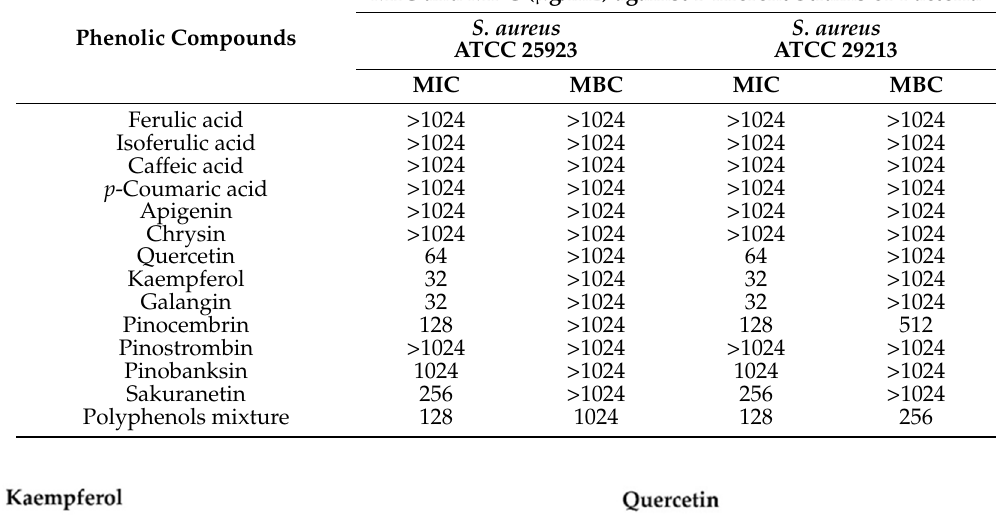
Table 6. Antimicrobial activity of propolis polyphenols and polyphenols mixture against clinical isolates of S. aureus (MSSA and MRSA).